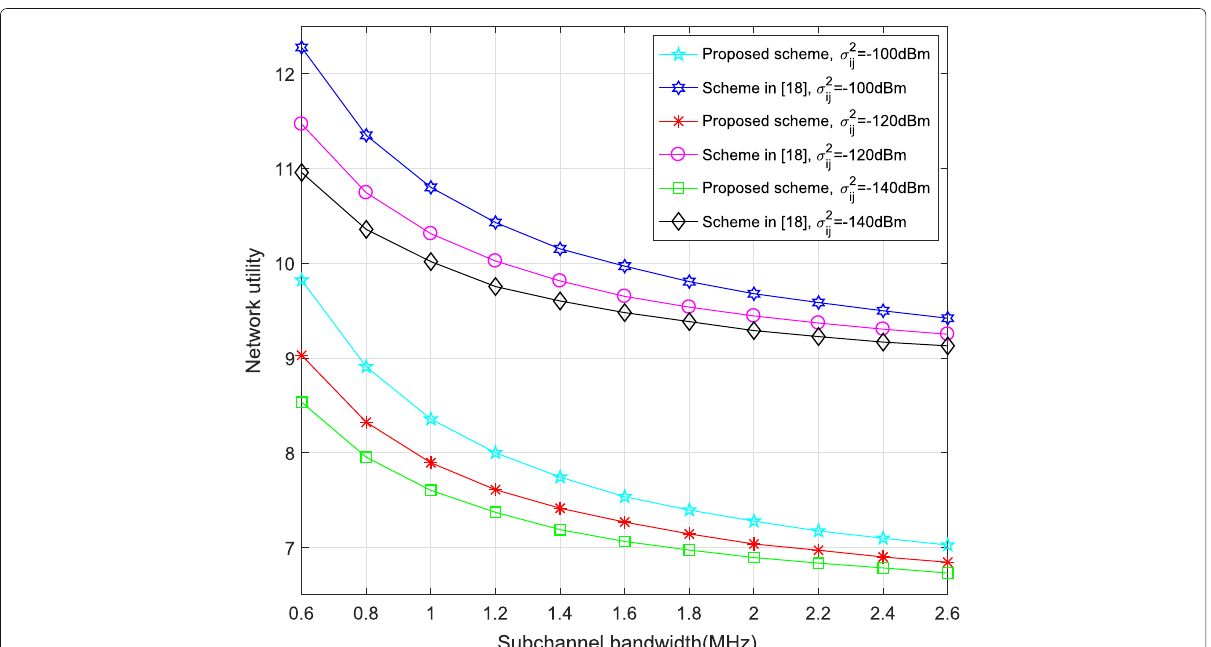
Fig. 6 Network utility versus subchannel bandwidth (different noise power). The network utility of the system versus the subchannel bandwidth for different noise power